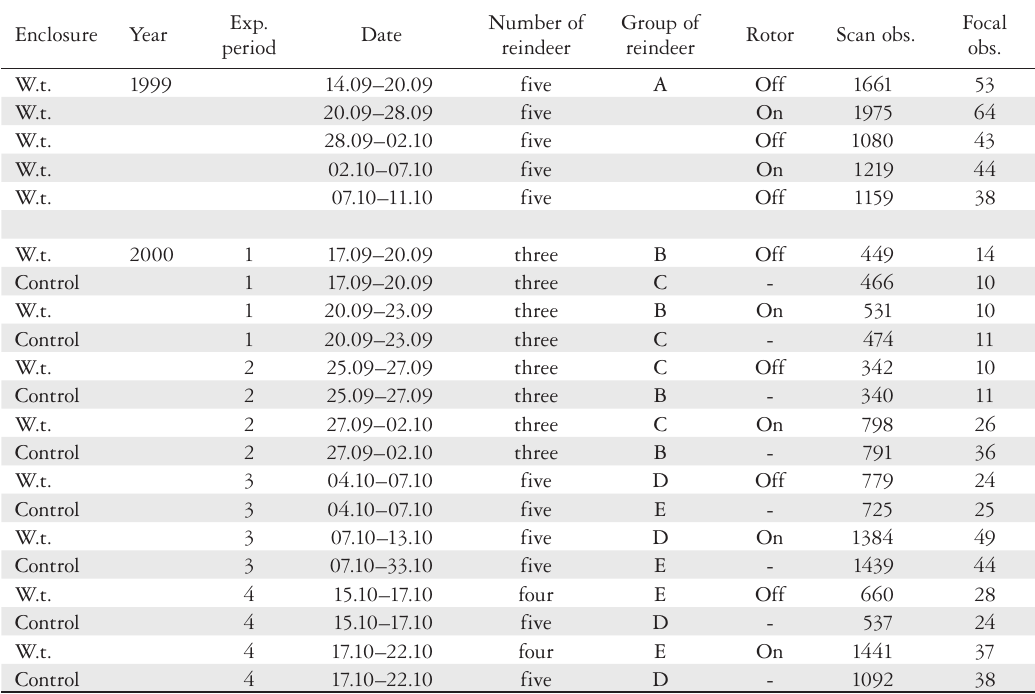
Table 1. Periods with wind turbine (W.t.) rotor turned on and off and number of observations during experimental periods with different groups of reindeer.